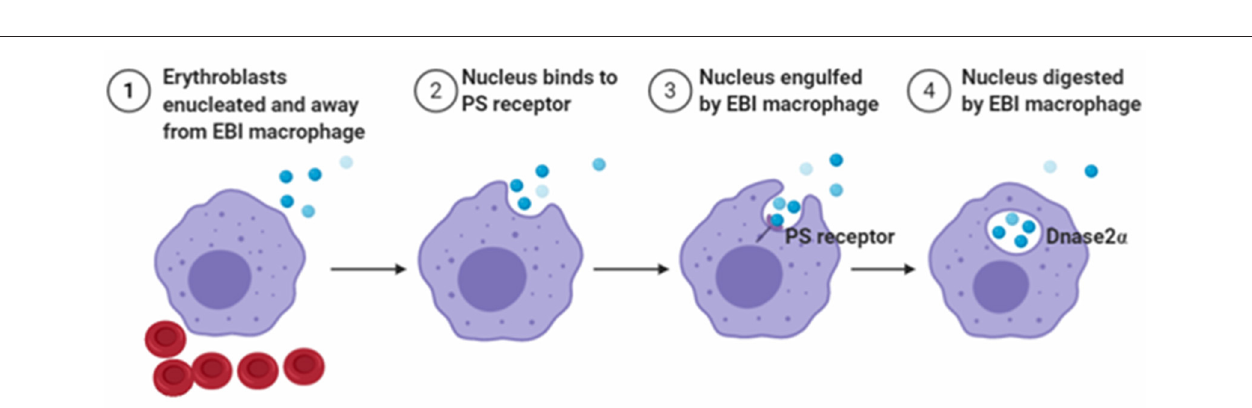
FIGURE 4 | Schematic diagram of nucleus engulfed and digested by EBI macrophages.